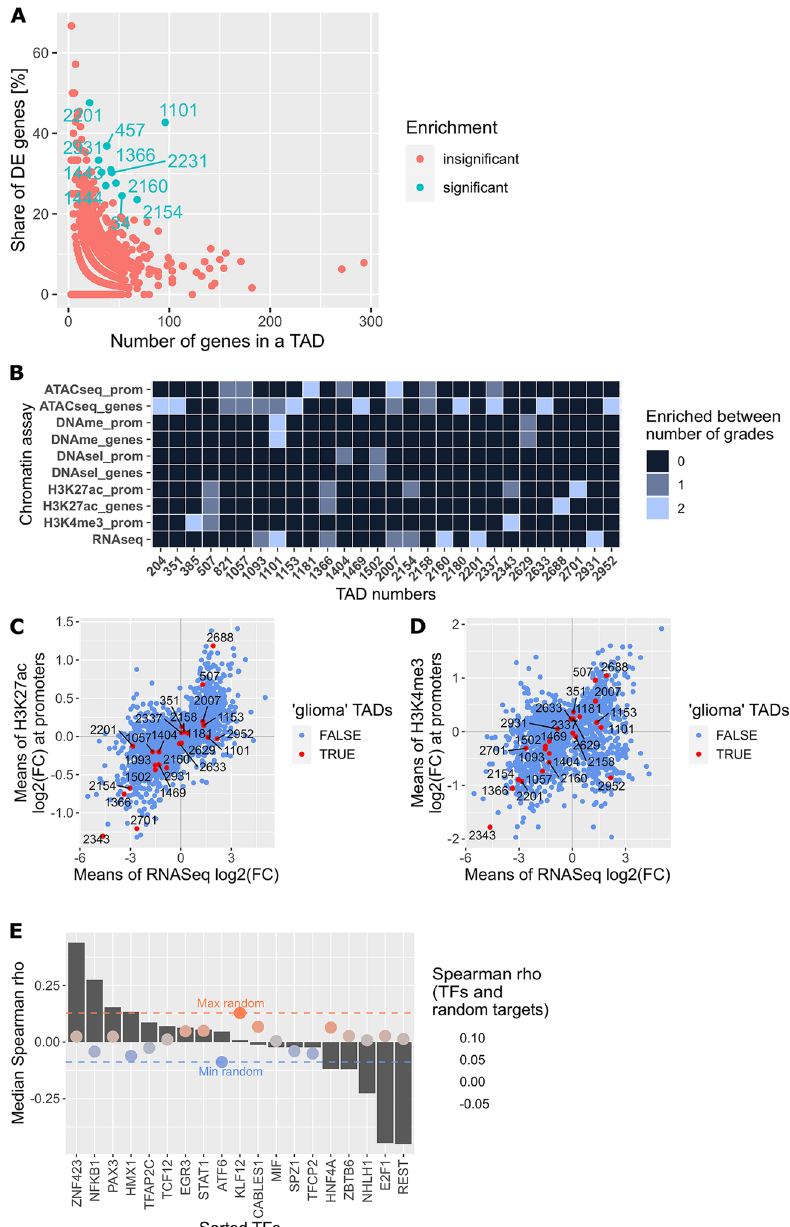
Figure 2. Discovering TADs enriched in genes differentially expressed and epigenetically modified in gliomas of different malignancies. ( A ) TADs enriched for DEGs or genes with DEMs deposited at their promoters, in the PA vs GBM/pGBM comparison. ( B ) TADs with exceptionally high proportion of DEGs and genes carrying DEMs in all grades comparisons. Colour scale depicts in how many of the three grade-comparisons a particular TAD was found to be enriched. ( C ) Dotplot showing means of DEGs expression and H3K27ac peak signals fold changes between PA and GBM/pGBM samples. Each dot represents a mean for each TAD. Dots in red mark the most enriched TADs (‘glioma TADs’, binomial test Benjamini–Hochberg corrected p < 0.05). ( D ) As in Fig. 2C for H3K4me3. ( E ) Spearman correlation between gene expression levels of enriched TFs and their target genes within TAD 2337. Grey bars depict median Spearman correlation between expression levels of genes encoding TFs and their target genes. Red and blue lines demarcate maximal and minimal correlation between expression levels of TF-coding genes and randomly selected, active genes. Colours of dots show median level of Spearman correlation between TFs and random target genes (red—positive correlation, blue—negative